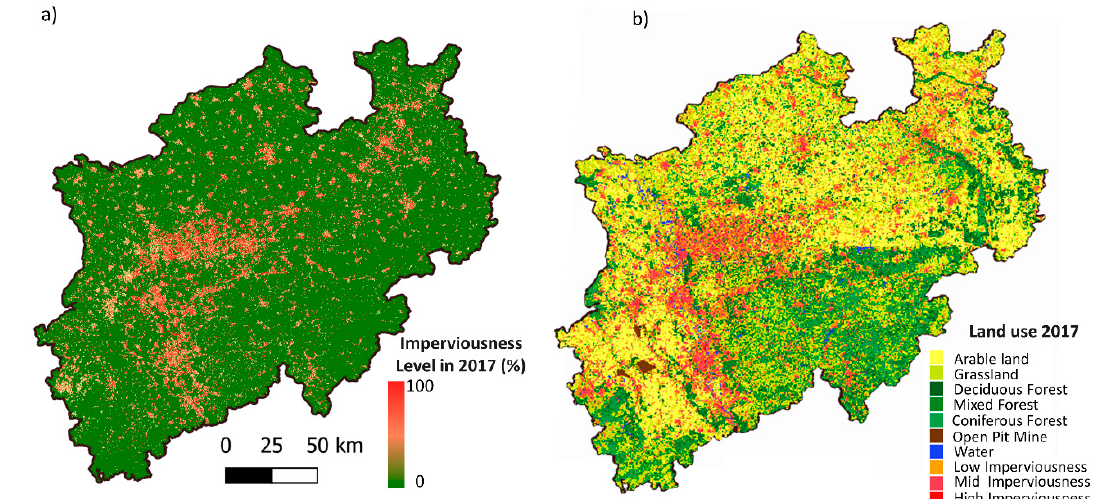
Figure 3. ( a ) The level of imperviousness for 2017 based on ATKIS data and RF regression, and ( b ) resulted land use map for 2017 baseline time step. Table 2. Accuracies of obtained maps.